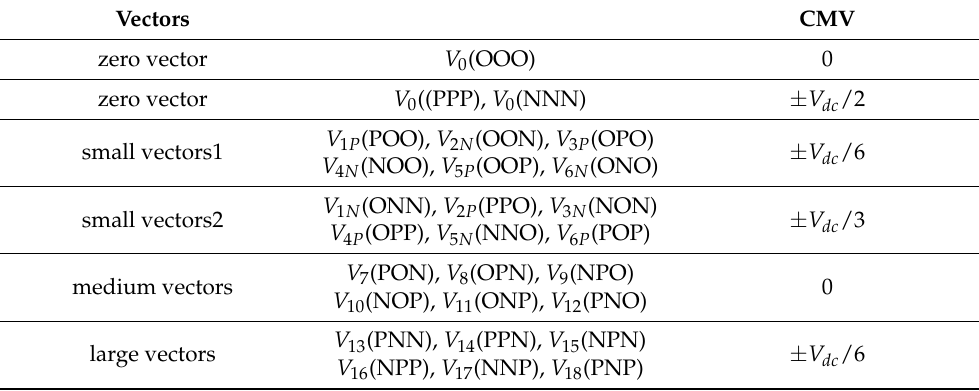
Table 3. Generated CMV by different space